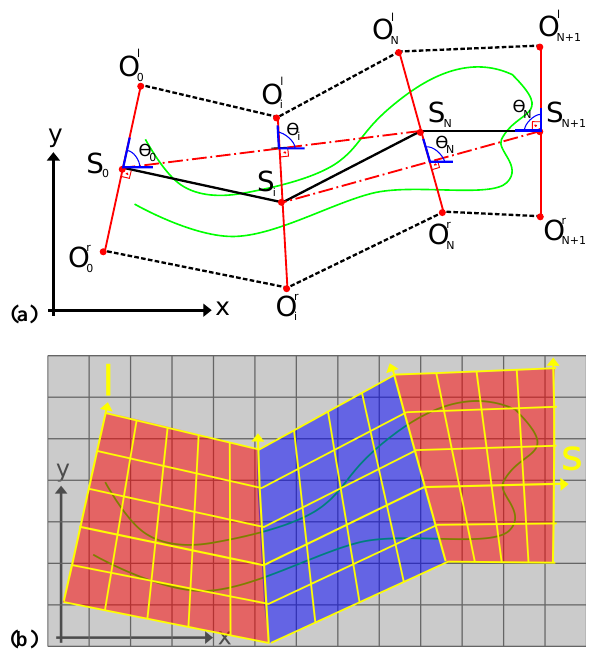
Fig. 3. Sketched simulation results (e.g. 1kPa; green) superimposed with avalanche path domain and new coordinate system along the central flow line z(x,y) . (a) Points of the central flow line S i and domain of width w with domain boundaries O l responding deviation angle θ i are shown. (b) Original raster (gray) with coordinates x,y , superimposed by irregular, path dependent raster (yellow) with coordinates s,l . Blue and red shadings mark the different path domain